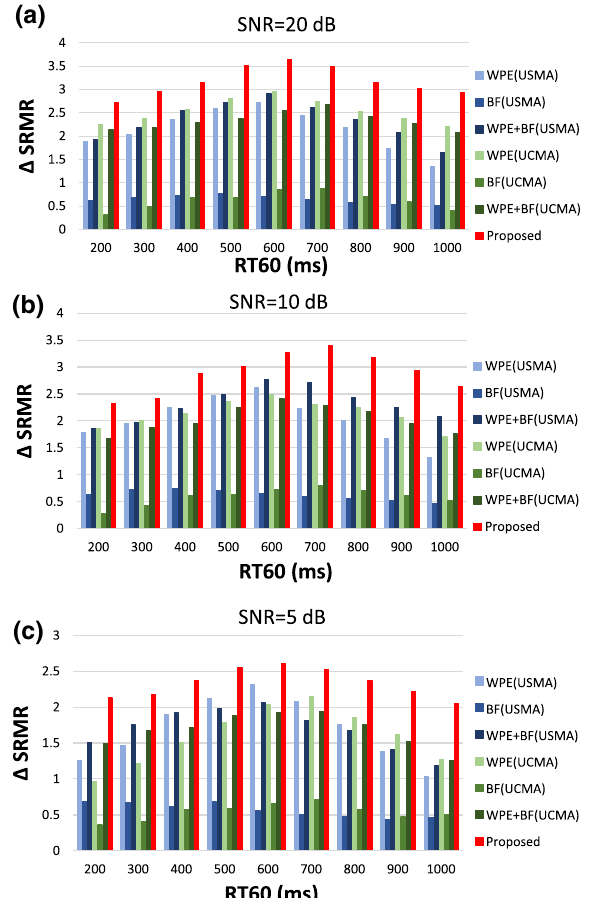
Fig. 11 (cid:31) SRMR changes in proportion to RT60 for beamforming (BF), dereverberation (WPE) and their combination (WPE BF) with the USMA and the UCMA geometries in comparison to the proposed + approach in three noise levels